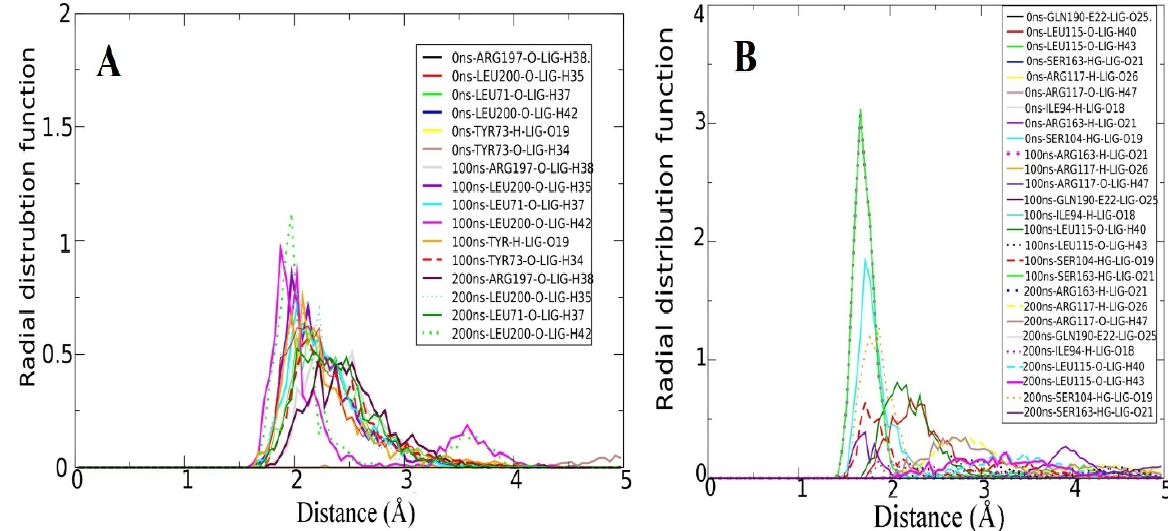
Figure 5. RDF plots of interactions between MvfR and leads that were constantly noticed during molecular dynamics simulation. ( A ) Top-1 lead. ( B ) Top-2 lead.